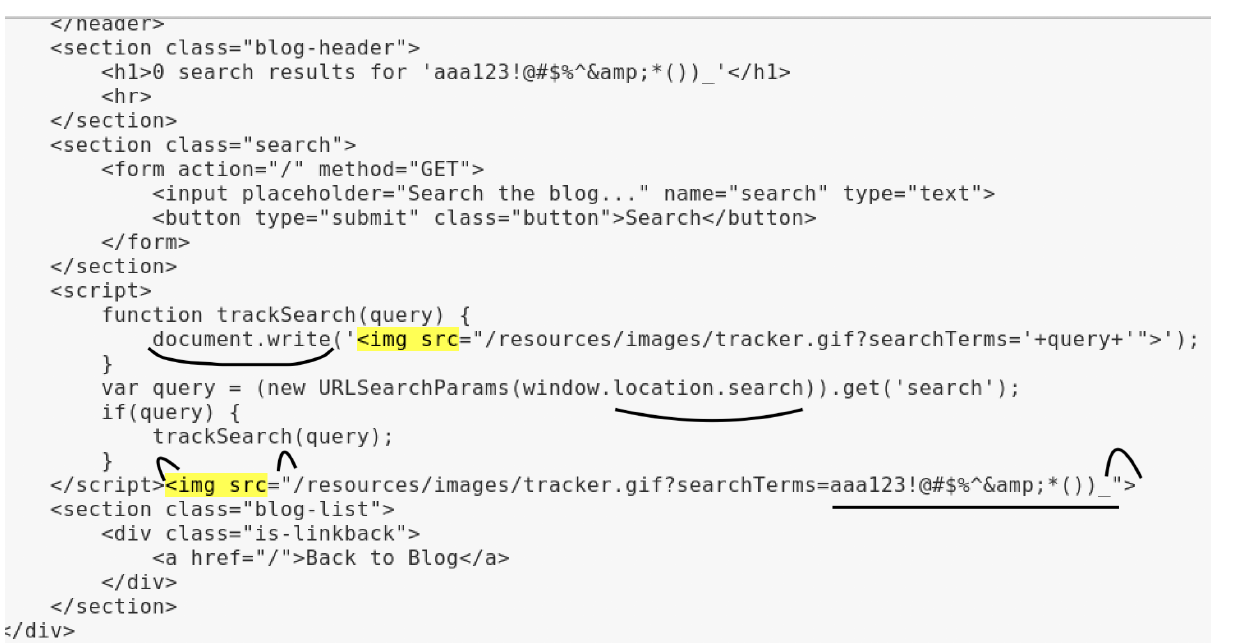
Figure 6. DOM-XSS demonstration in